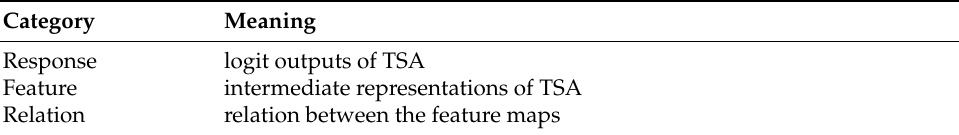
Table 2. KD Classification according to Knowledge Type.